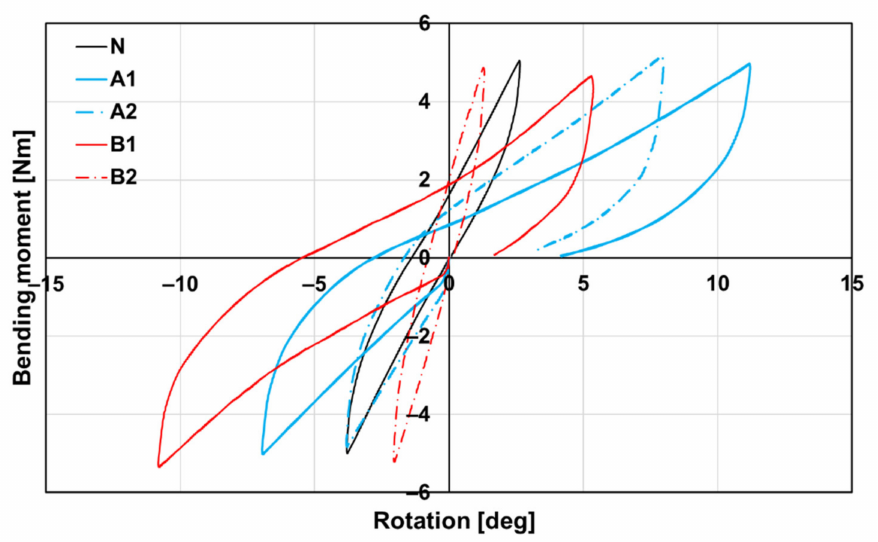
Figure 12. Dependence of bending moment on rotation according to groups A1, A2, B1, B2, and N (native bone) of spine cadavers. The steeper curve, the stiffer spine cadaver.